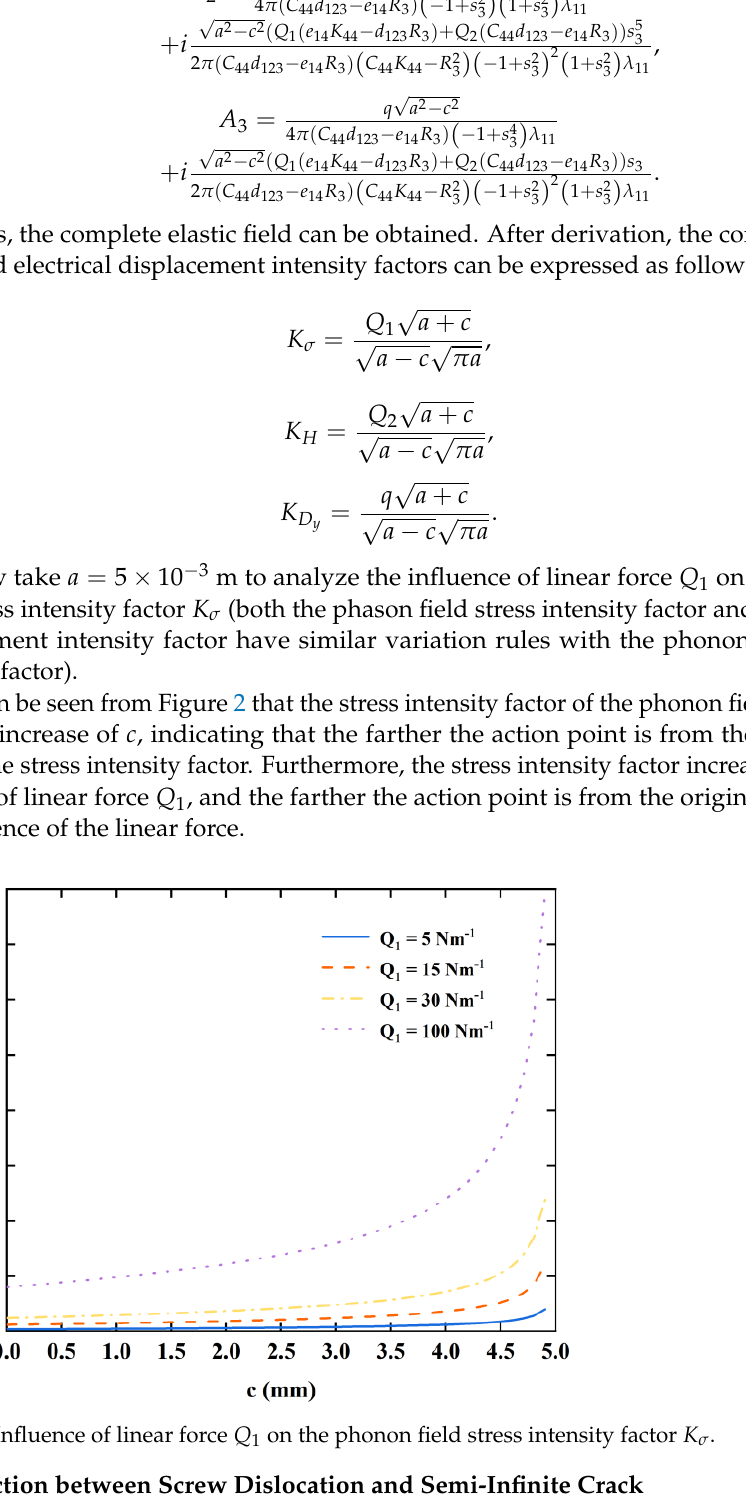
𝐵 𝑘 (𝑧 𝑘 − 𝑐)√𝑧 𝑘 , (𝑘 = 1,2,3). (32) the constants 𝐵 𝑘 = 𝛾 𝑘 + 𝛿 𝑘 𝑖 (𝑘 = 1,2,3). When 𝑥 < 0 , make 𝜎 𝑦𝑧 = 0, 𝐻 𝑦𝑧 = 0, 𝐷 𝑦 = 0 , we have the following: